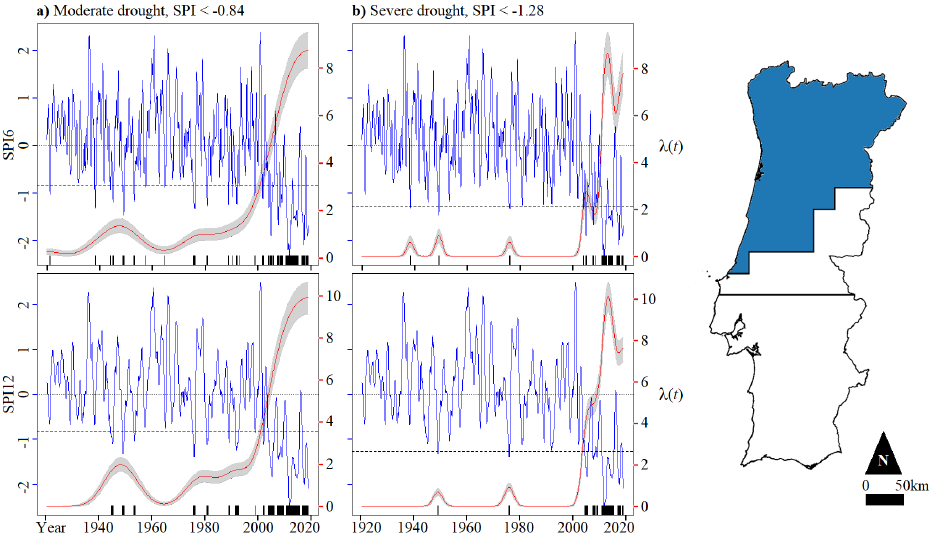
Figure 9. Northern region. Time dependent occurrence rates, λ ( t ) (year − 1 ), in red, and confidence band in grey of ( a ) moderate and ( b ) severe droughts for SPI6 and SPI12 in blue. The horizontal- dashed lines different to zero represent the drought thresholds and vertical ticks, with SPI below them.